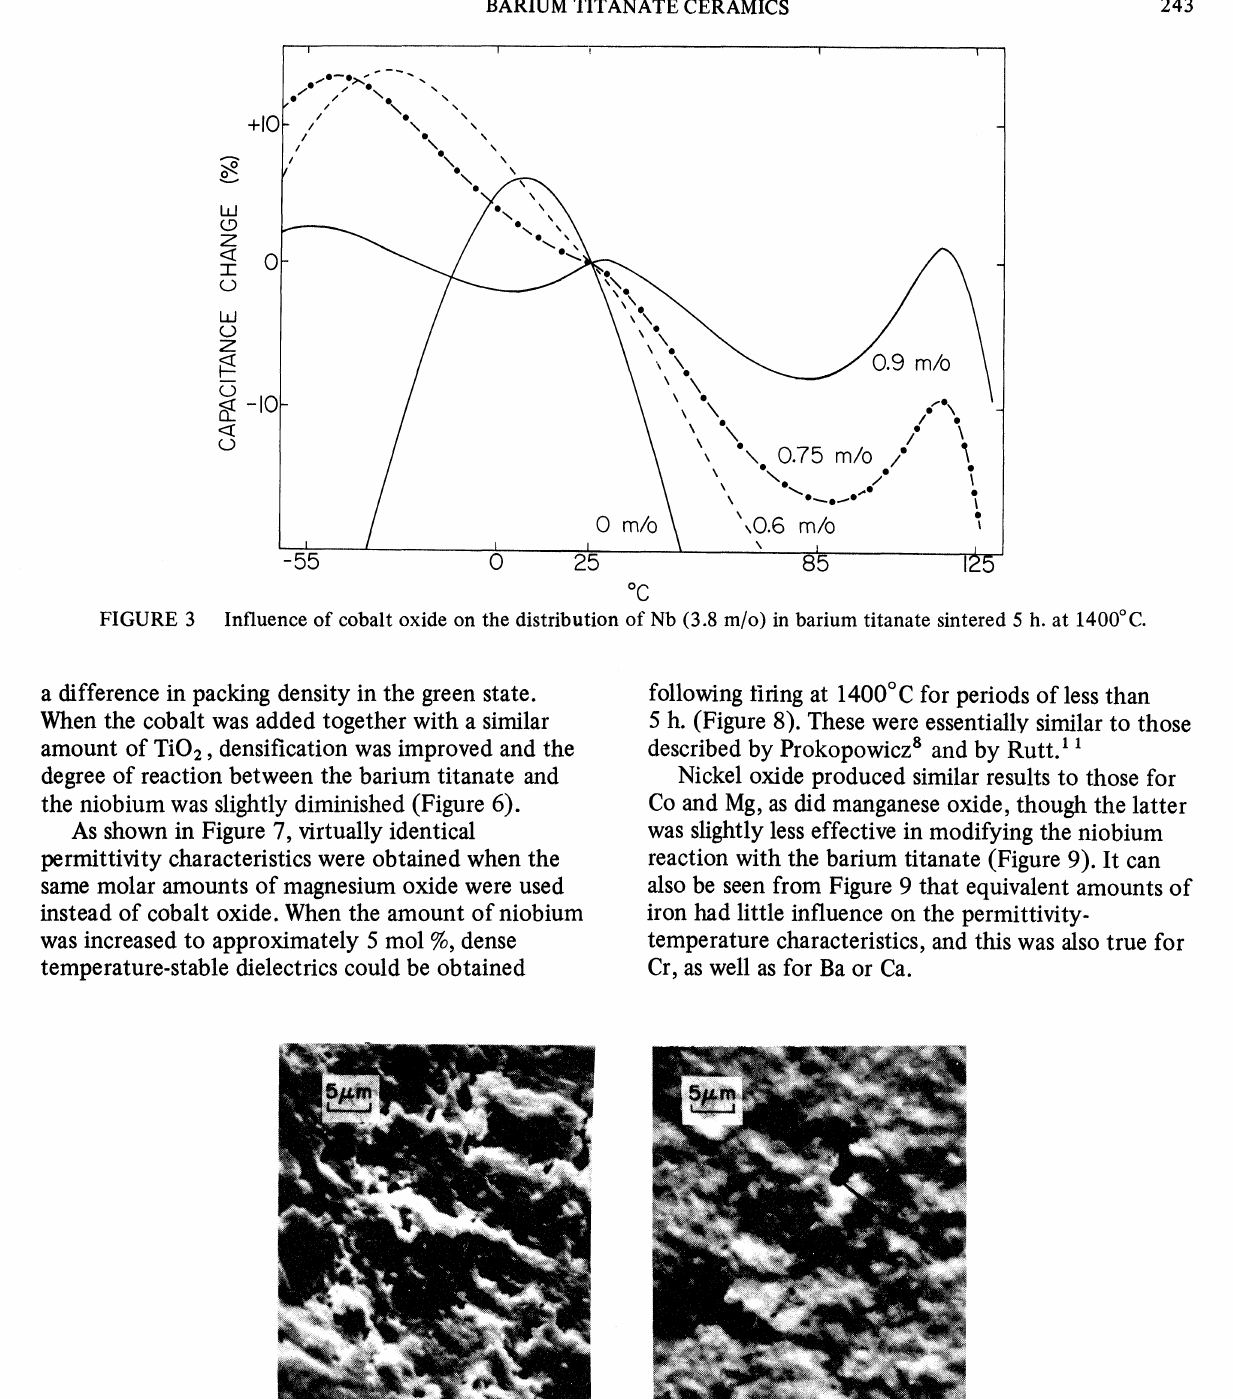
Increase in porosity with cobalt oxide additions to barium titanate with 3.8 m/o Nb sintered 5 h. at 1400C. (a) 0 m/o Co, (b) 0.9 m/o Co. Fractured